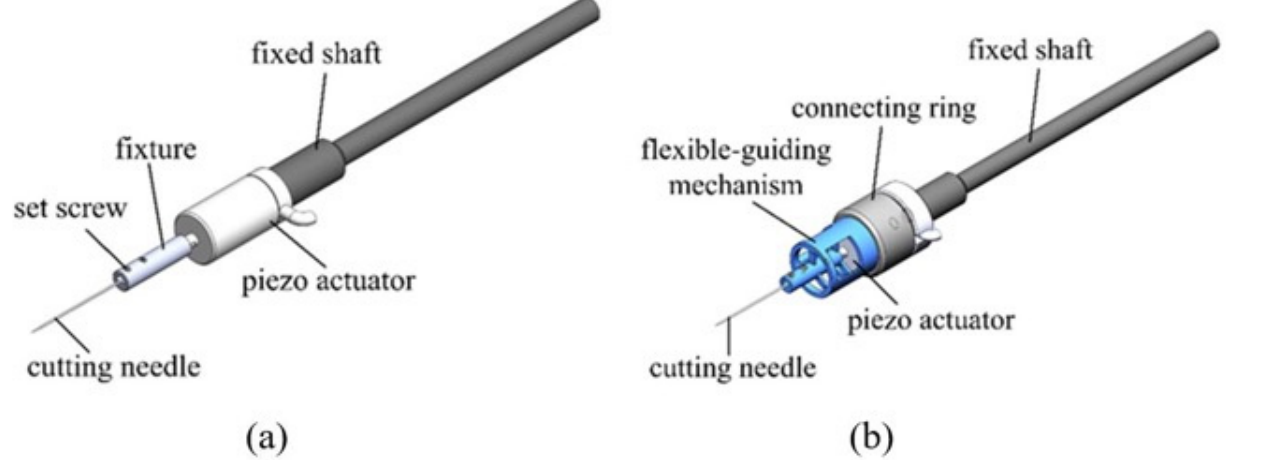
Figure 1. Two piezoelectric ultrasonic microdissection devices: ( a ) Piezoelectric microdissection device with traditional structure; ( b ) piezoelectric microdissection device based on flexure mechanism.